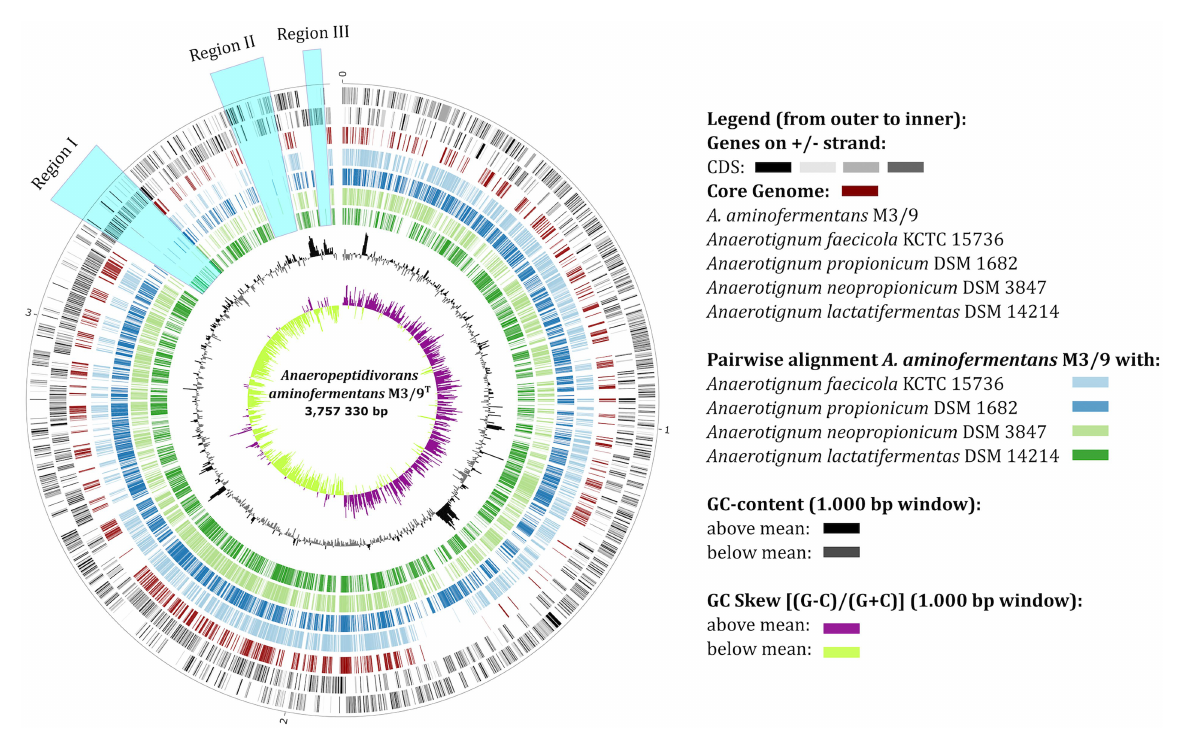
FIGURE 4 Multi-genome circular plot visualizing the orthologous genes in the genomes of A. aminofermentans M3/9 T and closely related Anaerotignum strains . The black outer rings of the circular plot represent the genes of the A. aminofermentans M3/9 T genome. The further rings of the circular plot show the core genome (red) as well as the orthologs of each individual Anaerotignum genome in comparison to the reference.